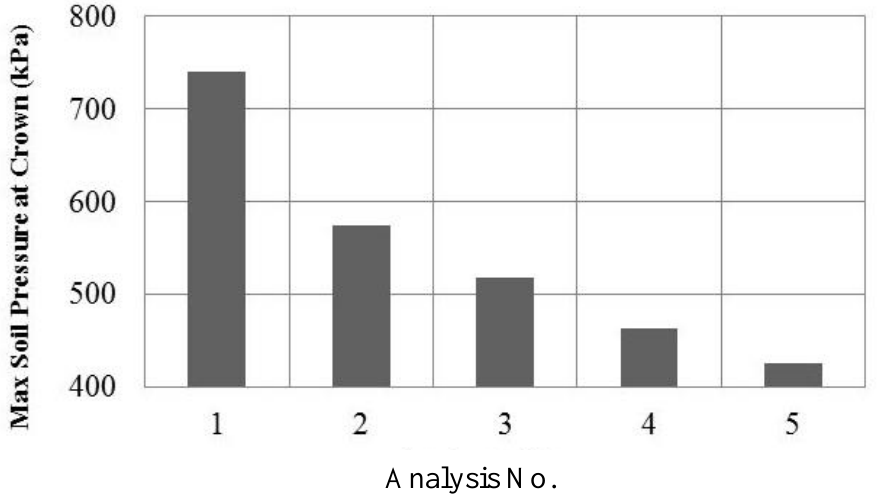
Fig. 6. Maximum pressure induced in the soil adjacent to the tunnel crown in different